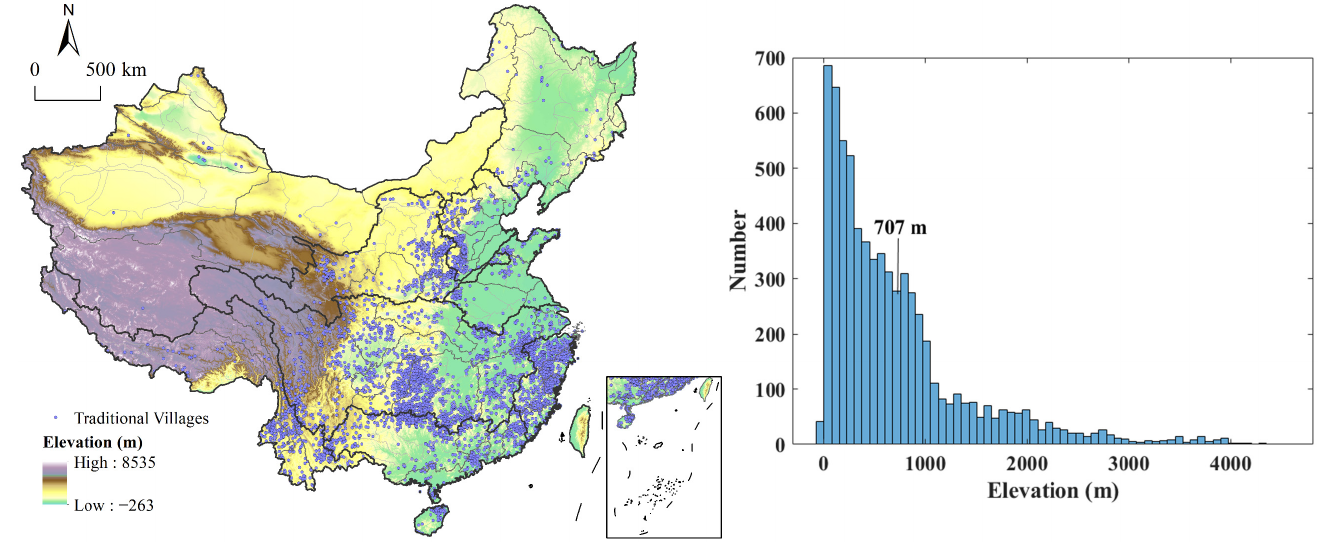
Figure 9. Relationships between traditional villages and elevation in China.